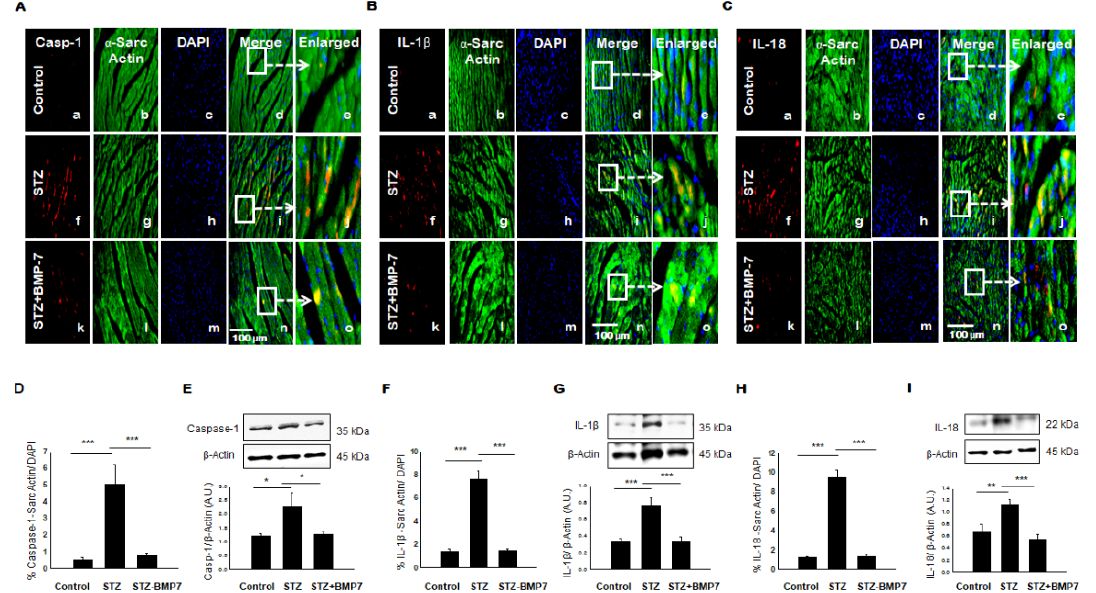
Figure 3. BMP-7 attenuates the expression of pyroptotic proteins caspase-1, IL-1 β , and IL-18 in the diabetic heart. ( A – C ) Representative photomicrographs of heart sections stained in control group (a–e), STZ group (f–j) and STZ-BMP7 group (k–o) with sarcomeric- α actin (green, stained cardiac myocyte) (b, g, l) and pyroptotic markers caspase-1 ( A ), IL-1 β ( B ) and IL-18 ( C ) in red (a, f, k) with nuclei stained (c, h, m) by DAPI in blue, merged (d, i, n) and enlarged (e, j, o) image. ( D , F , H ) Quantitative analysis-derived histograms of pryoptotic caspase-1 ( D ), IL-1 β ( F ), and IL-18 ( H ) +ve cardiomyocytes (colocalization of both red and blue DAPI in green cardiomyocyte) were quantified over total DAPI in heart sections of mice. ( E , G , I ) Representative Western blots and densitometric analysis of caspase-1 ( E ), IL-1 β ( G ), and IL-18 ( I ) markers are shown. Quantities are presented as an arbitrary unit (A.U). Statistical analysis was performed using One-Way ANOVA, which was followed by the Tukey test. Error bars= mean ± S.E.M. * p < 0.05, ** p < 0.01, *** p < 0.001; Scale bar = 100 µm; n = 16/group.